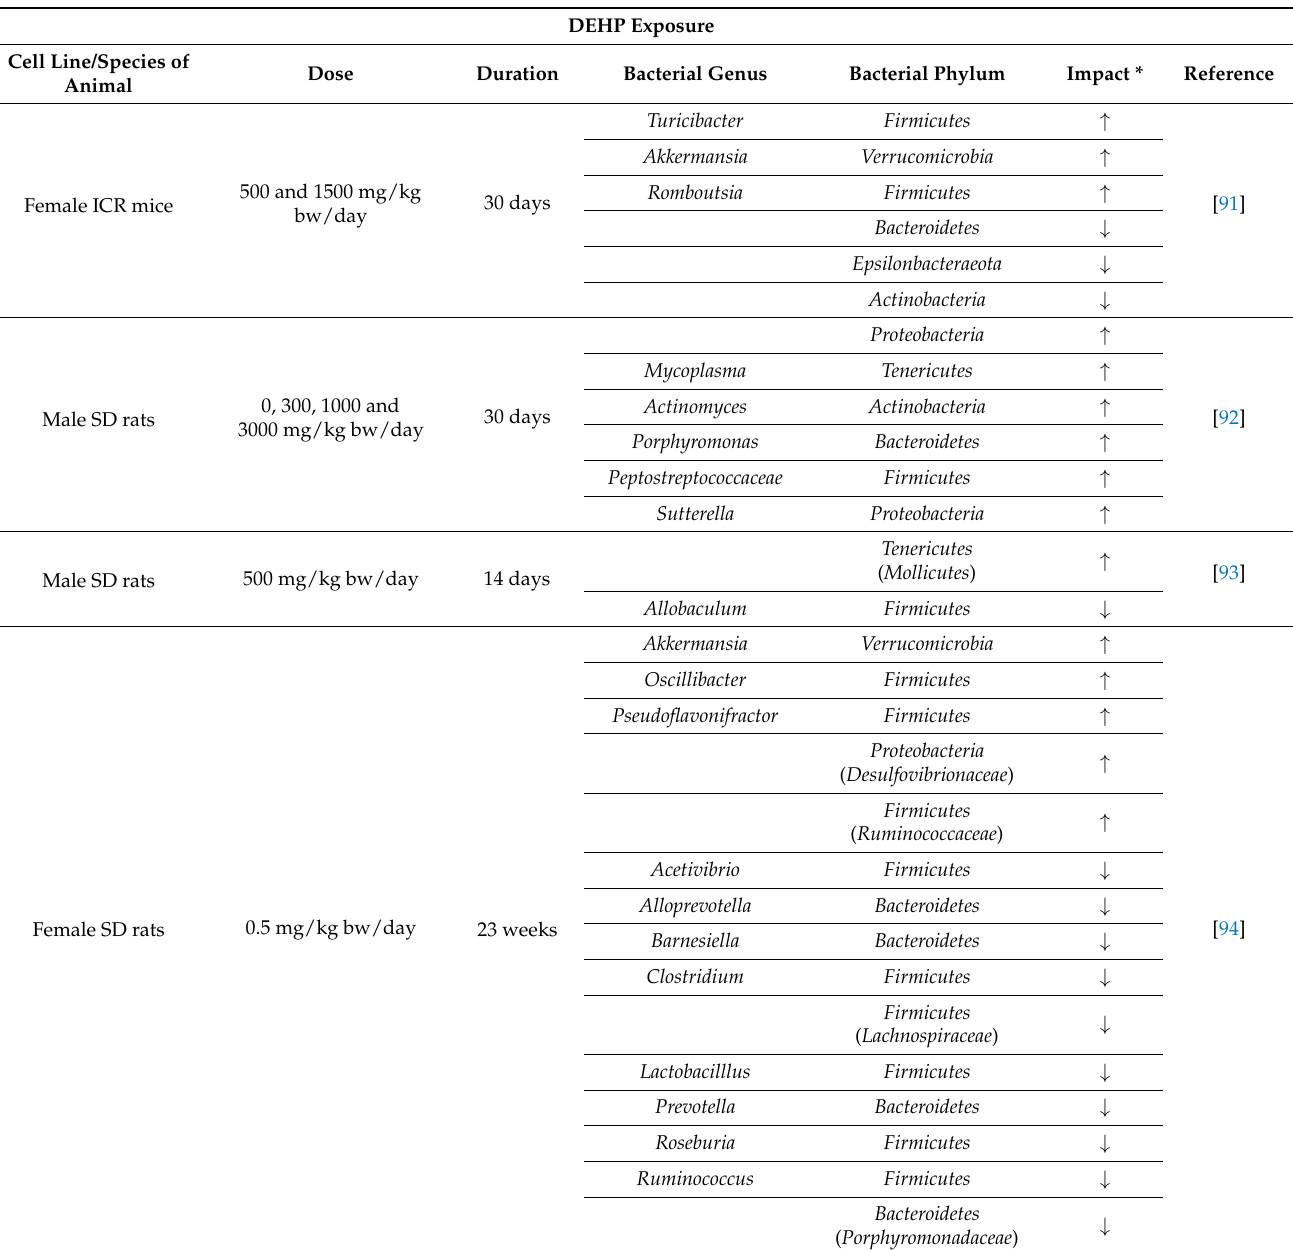
Table 3. Studies on exposure to DEHP and its relationship with the intestinal